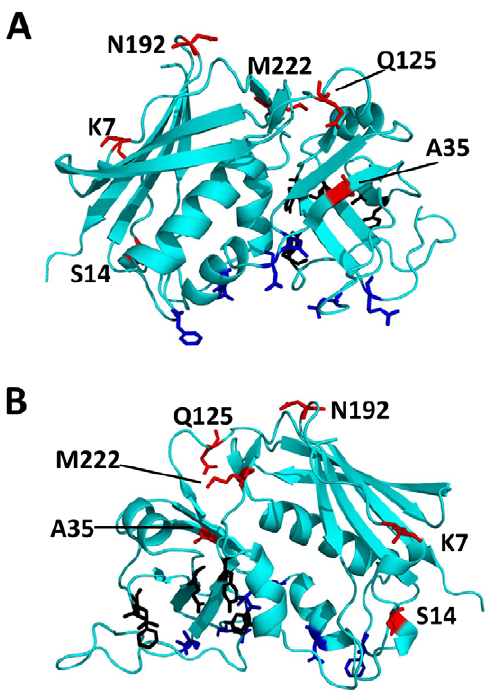
Figure 2. Amino acid substitutions in variants of SEB are not predicted to occur in regions that contact immune cell receptors. A and B are representations of the crystal structure of SEB shown from two different angles. Residues that contact the V b -TCR are highlighted in blue and residues that contact MHC II DR1 are highlighted in black. The amino acid substitutions found in variants of SEB are highlighted in red.